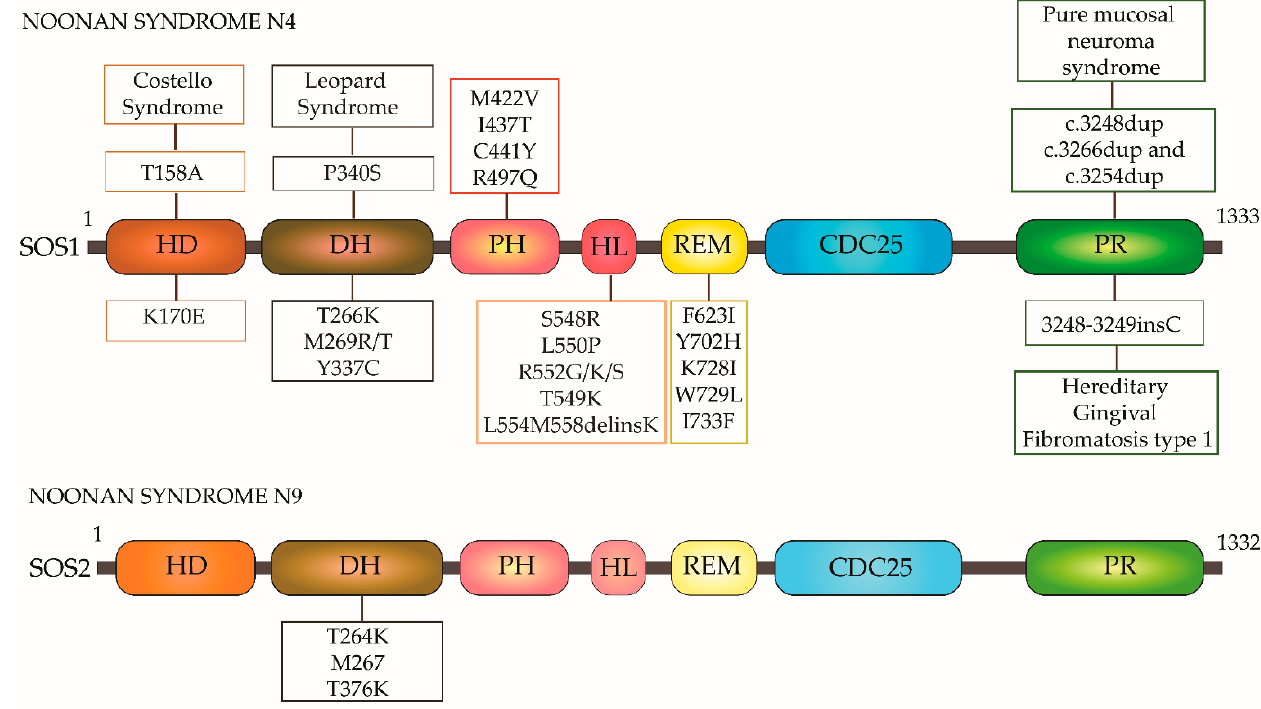
Figure 4. The various mutant residues of SOS1 In Noonan syndrome 4 (NS4), hereditary gingival fibromatosis type 1 (HGF-1), pure mucosal neuroma syndrome, Costello syndrome (CS), and Leopard syndrome (LPRD). SOS2 shares ~70% sequence similarity with SOS1 and mutation in its DH domain leads to Noonan syndrome 9 (NS9).